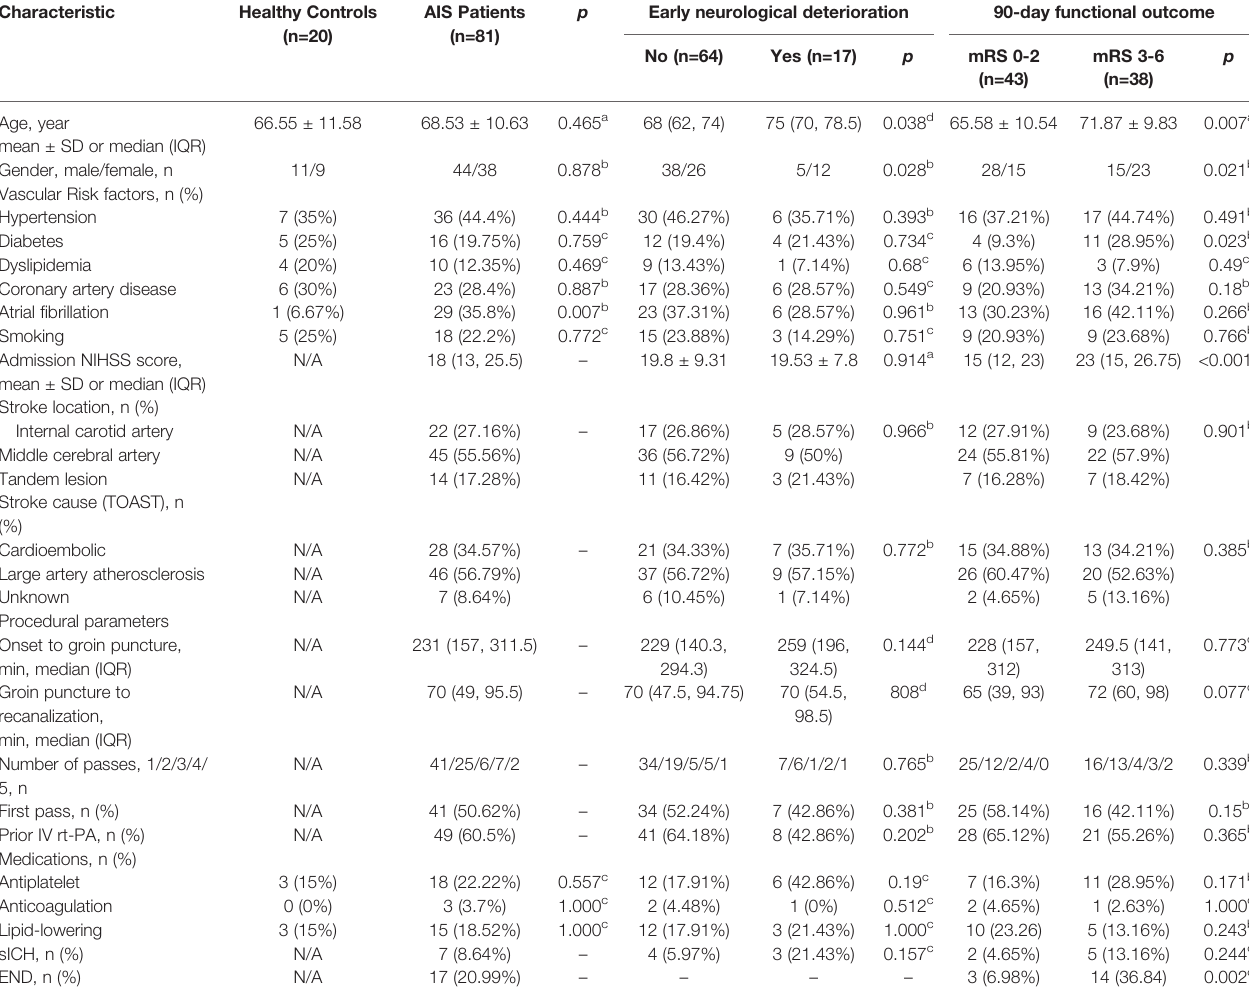
TABLE 1 | Baseline characteristics of the study